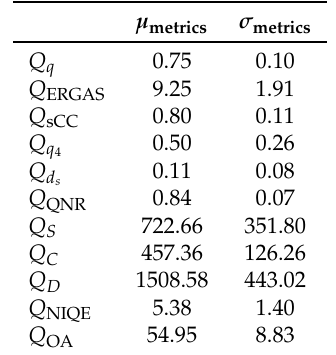
Table 2. Means and standard deviations of quality scores from 11 reduced resolution and full-resolution quality metrics. In this case, each algorithm analyzed 125 PS images affected by three different levels of blur distortion.